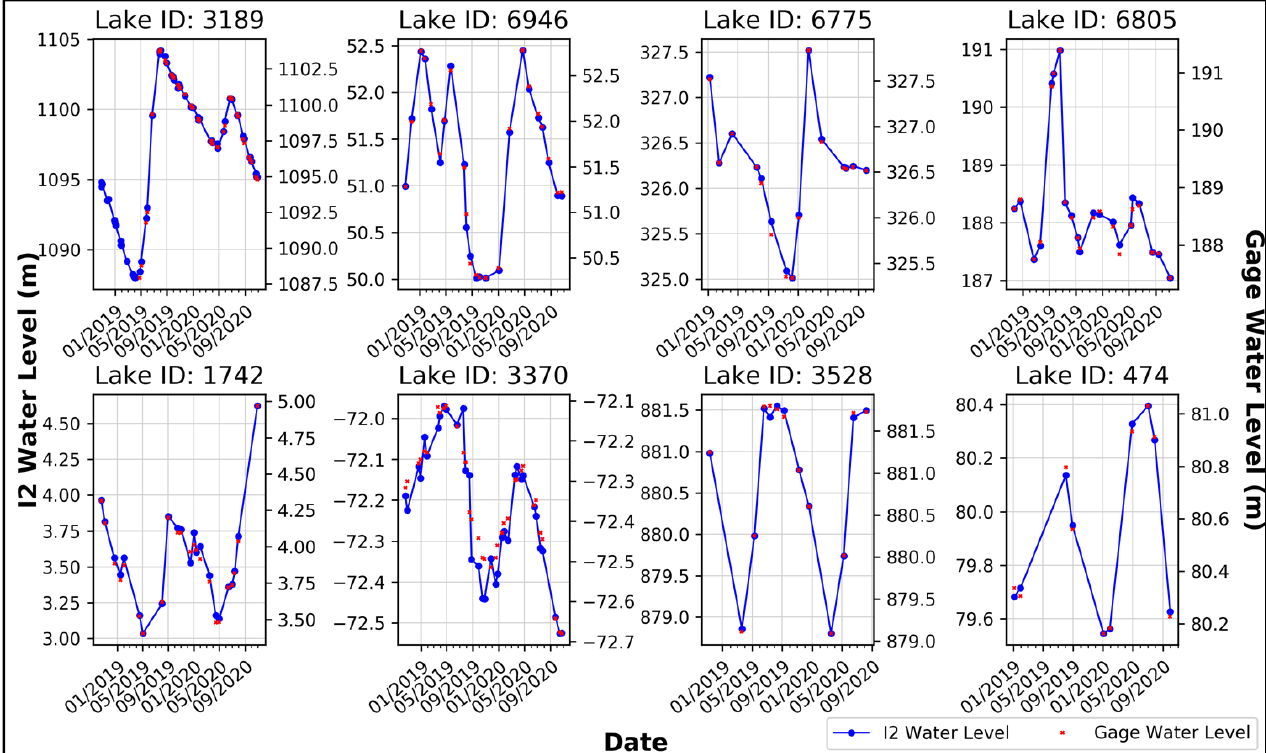
Figure 4. Comparison of IS-2 and gage derived water level time series for eight selected reservoirs and lakes. The first row consists of reservoirs and the second row consists of natural lakes. IS-2 water levels (blue) are orthometric (EGM2008) and gage water (red) levels are based on the individual gages’ reporting vertical datum. IS-2 water levels are plotted on the first y -axis (left) and the gage water levels are plotted on the second y -axis (right).